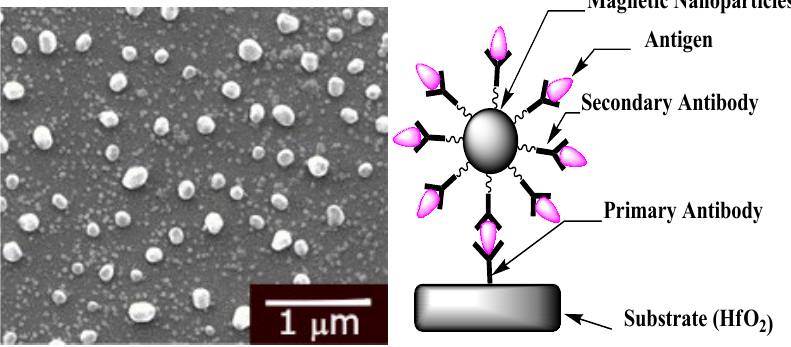
Figure 8. SEM image of functionalized TESUD substrates with Ab-Ag-Ab-MNP (magnetic nanoparticles) biorecognition: left side: SEM image; right side: scheme. Table 1. Fitting parameters obtained from the equivalent circuit of the cortisol-based HfO 2 immunosensor. Cortisol